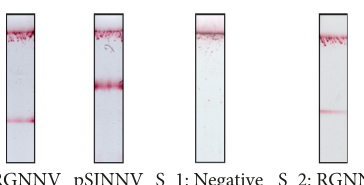
pRGNNV pSJNNV S_1: Negative S_2: RGNNV Figure 6: Visual detection of nodavirus genotype-specific products with dual lateral flow biosensors. Representative LFBs with am- plification products of tetra-primer PCR performed with pRGNNV and pSJNNV reference plasmids and a healthy (S_1) and an in- fected (S_2) D. labrax